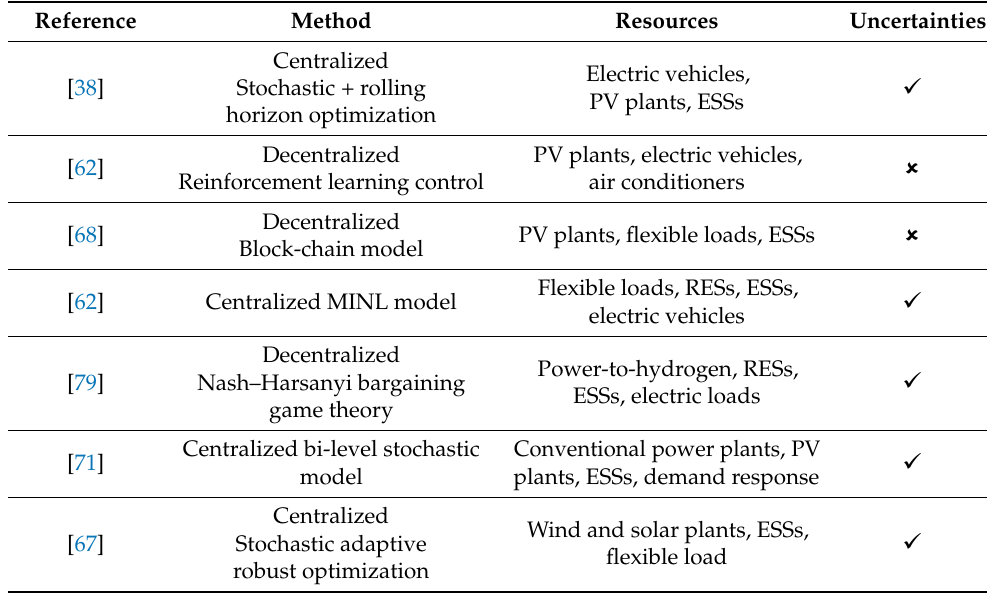
Table 3. Main research studies regarding the control and coordination strategies for aggregators. Reference